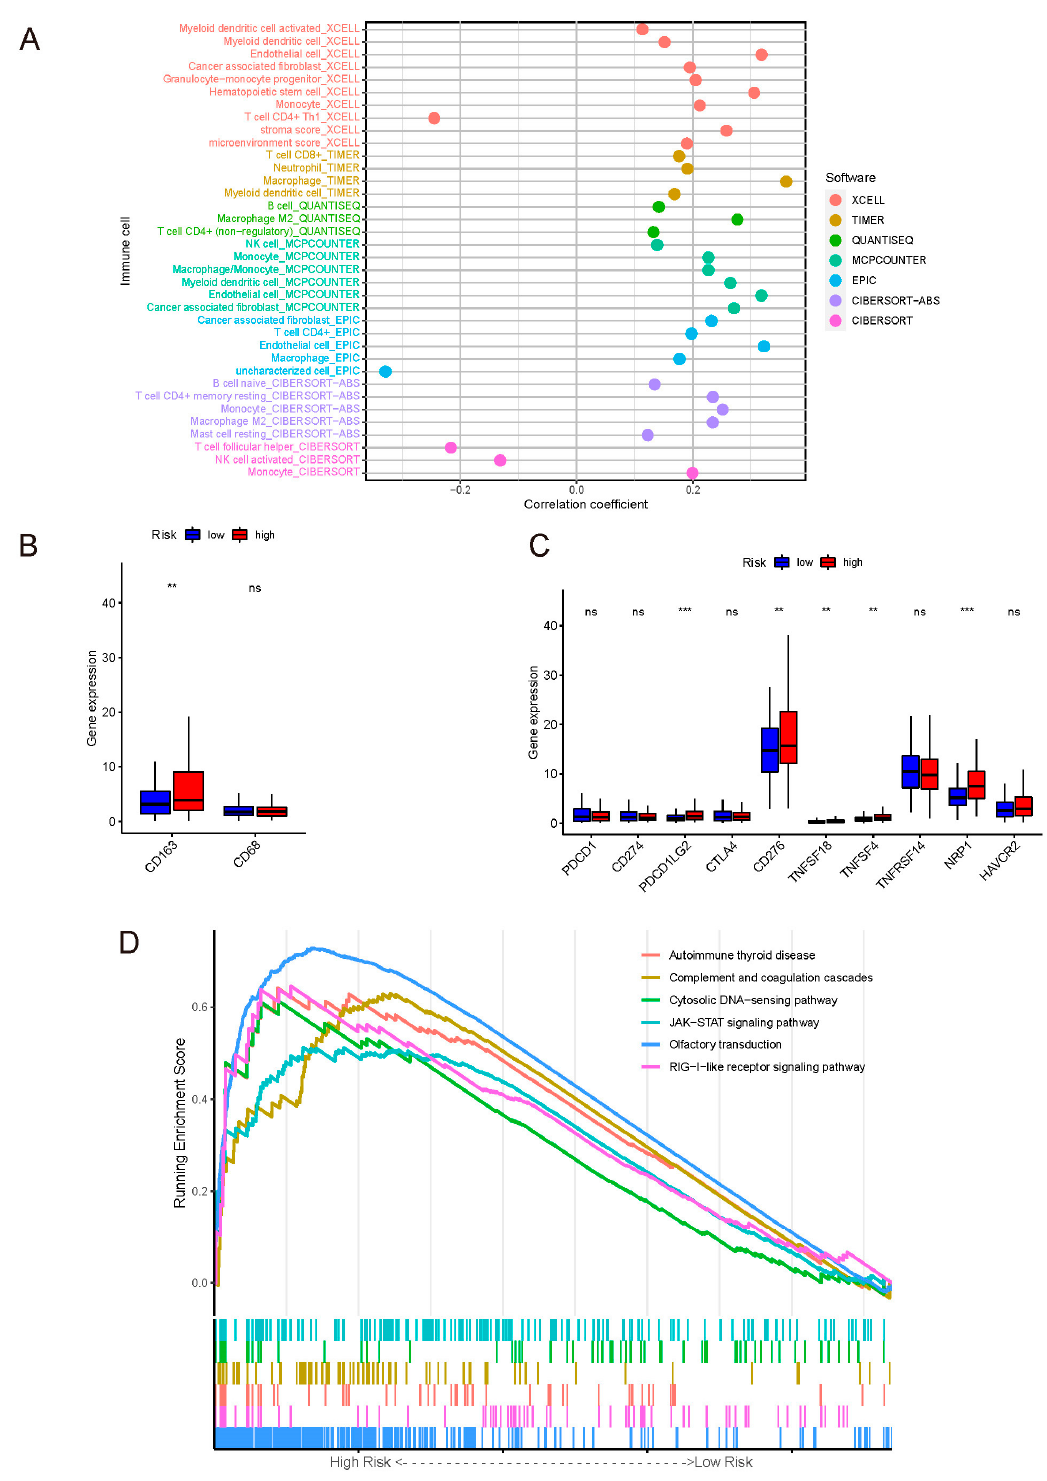
Figure 4. ( A ) Correlation coefficient dot plot of immune-cell infiltration abundance between the model and algorithms. Mono-macrophage system was positively correlated with the risk score in various algorithms. ( B ) Gene-expression levels of macrophages’ markers. Label: p < 0.01 = **, ns = not significant. ( C ) Gene-expression levels of immune check points. Label: p < 0.001 = ***, p < 0.01 = **, ns = not significant. ( D ) GSEA of the whole set.